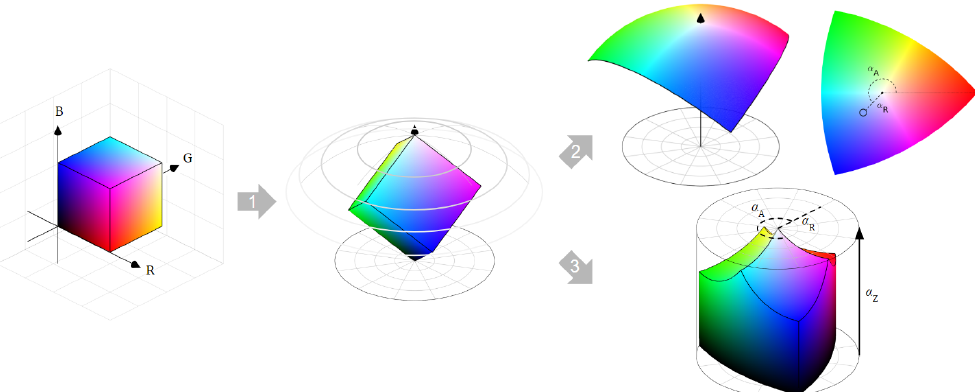
Figure 1. Geometric interpretation of the RGB-to-ARC conversion. Step 1 applies a rotation and a change in the coordinate system. Step 2 provides the transformation into the 2D ARC diagram. Step 3 provides the transformation into the 3D ARC space.